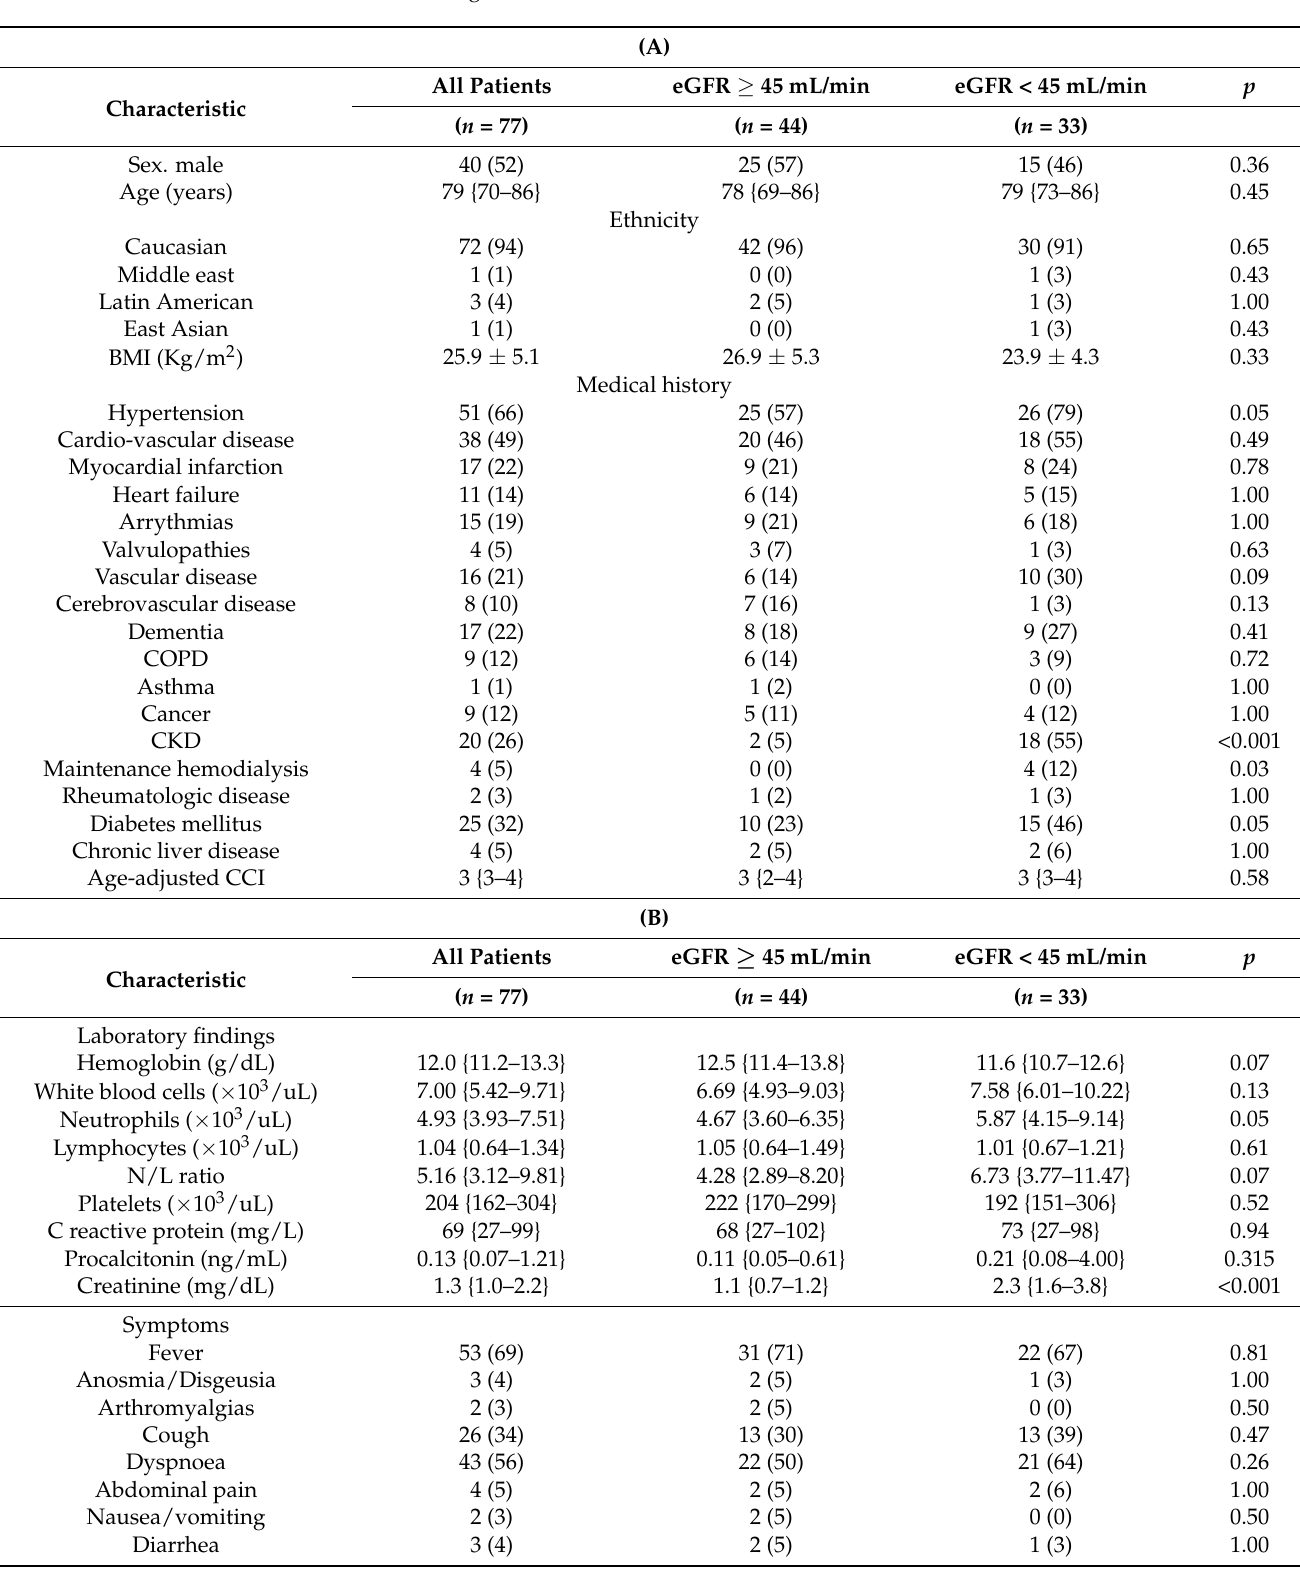
Table 1. ( A ) Patients characteristics. Demographics and comorbidities. ( B ) Patients’ characteristics. Clinical